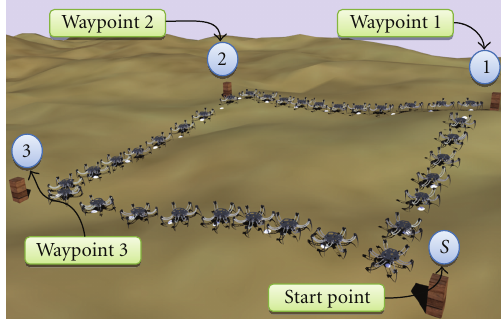
Figure 14: Pictorial representation of the path traced by the robot using the proposed FRC